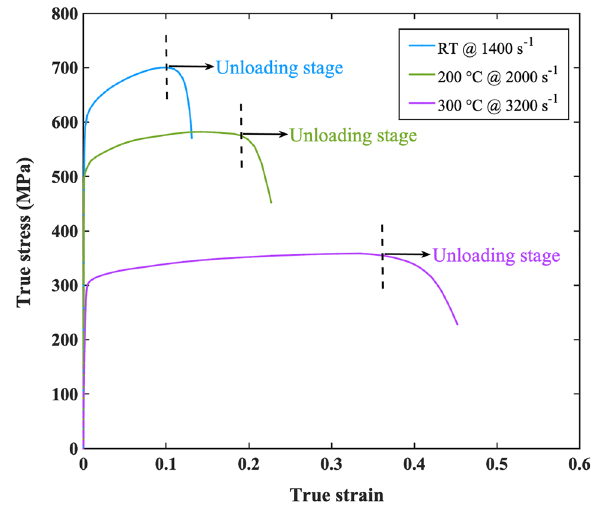
Fig. 3 True stress–strain curves at three representative experimen- tal conditions showing the unloading stage of the